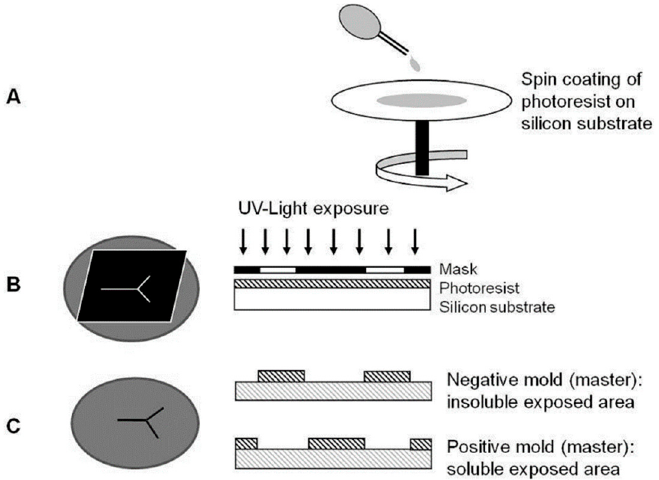
Figure 11. Schematic representation of the photolithographic fabrication technique. ( A ) A photoresist is spin-coated onto a silicon substrate. ( B ) The substrate with the spin-coated layer of photoresist is exposed to UV light through a high-resolution mask. ( C ) After baking and chemical development, the non-cross-linked material is removed, resulting in either a positive or a negative mold. Taken with permission from [111].